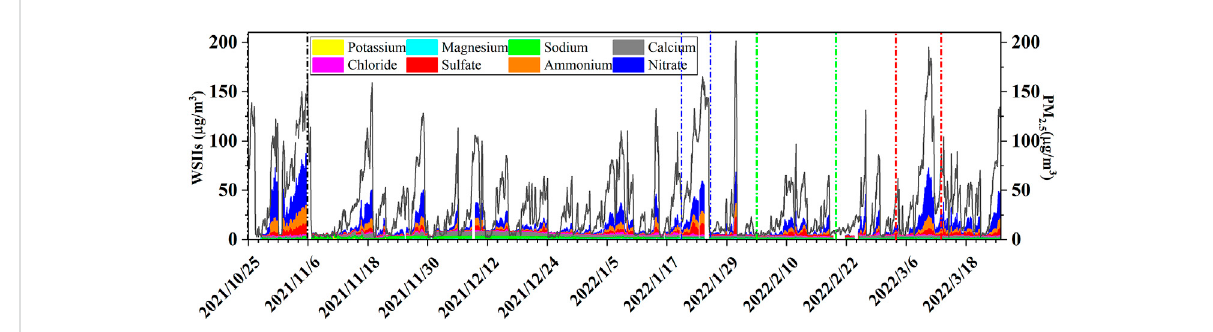
FIGURE 6 TimeseriesofPM 2.5 andWSIIsmassconcentration;theblackdottedlinesarethetestheatingtime;thebluedottedlinesrepresentsnowfall;the green dotted lines represent the Olympic Winter Games period, and the red lines represent the Paralympic Winter Games period.